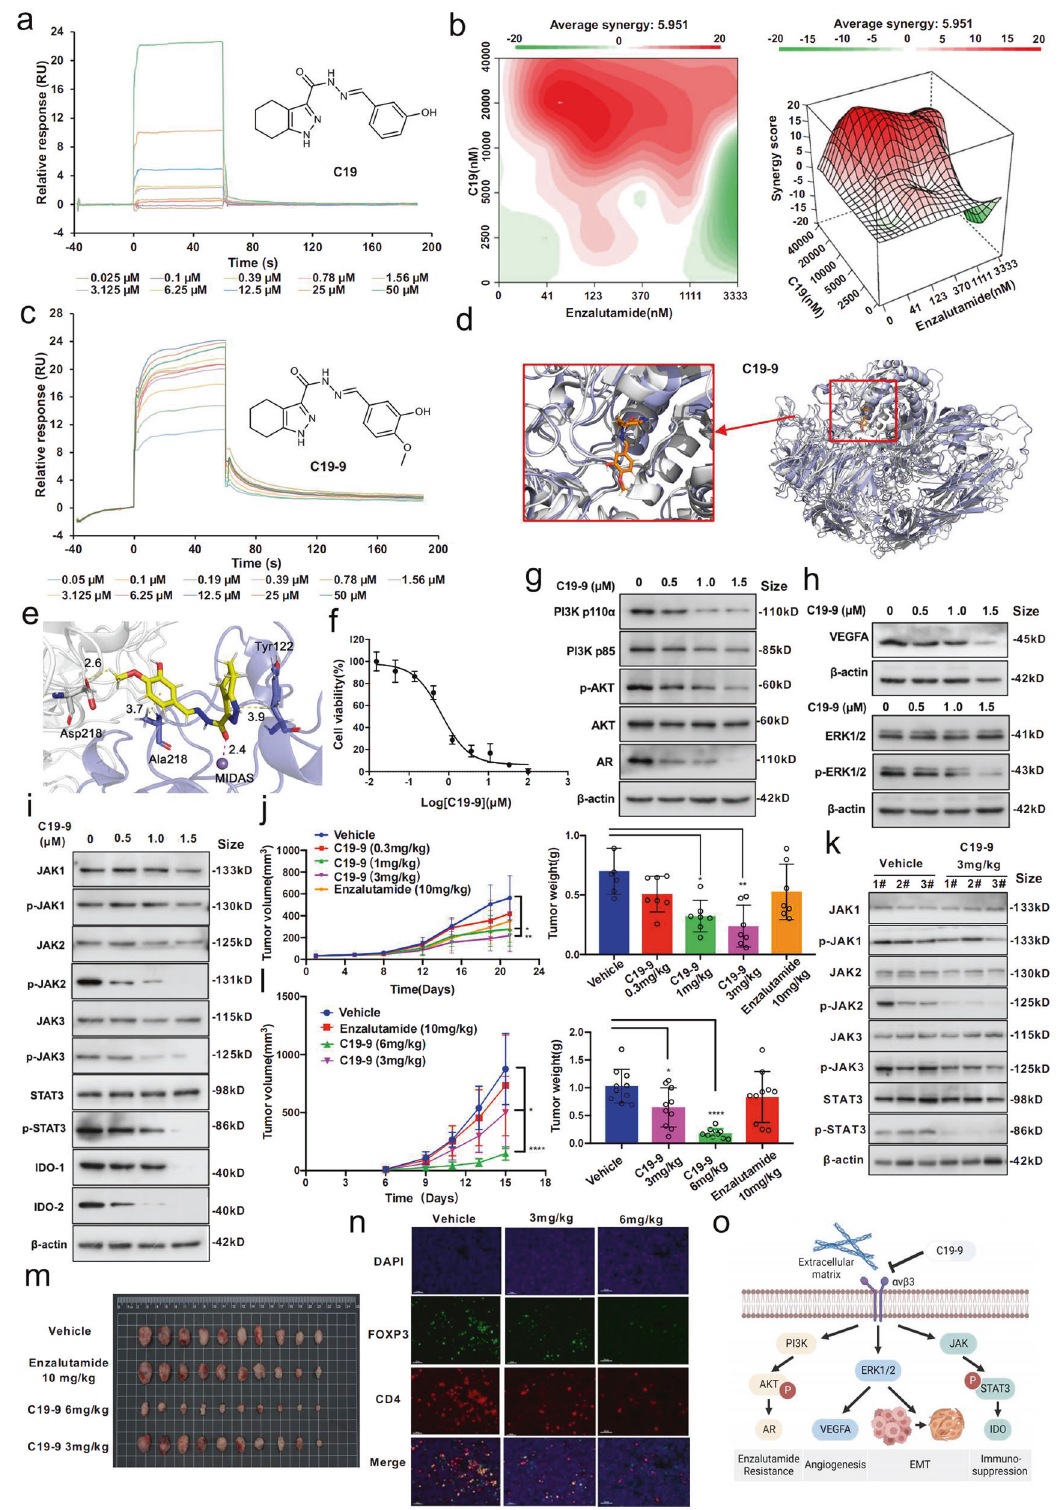
signi fi cantly affect the body weight of mice in acute and long- term toxicity experiments, and did not show apparent toxicity according to the pathological review of sections of the heart, liver, lung, and kidney (Supplementary Fig.